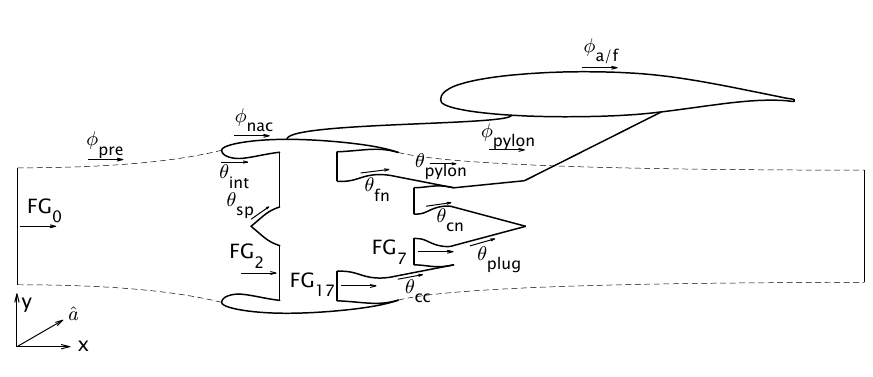
Figure 2. Forces acting on the nacelle and airframe for thrust–drag